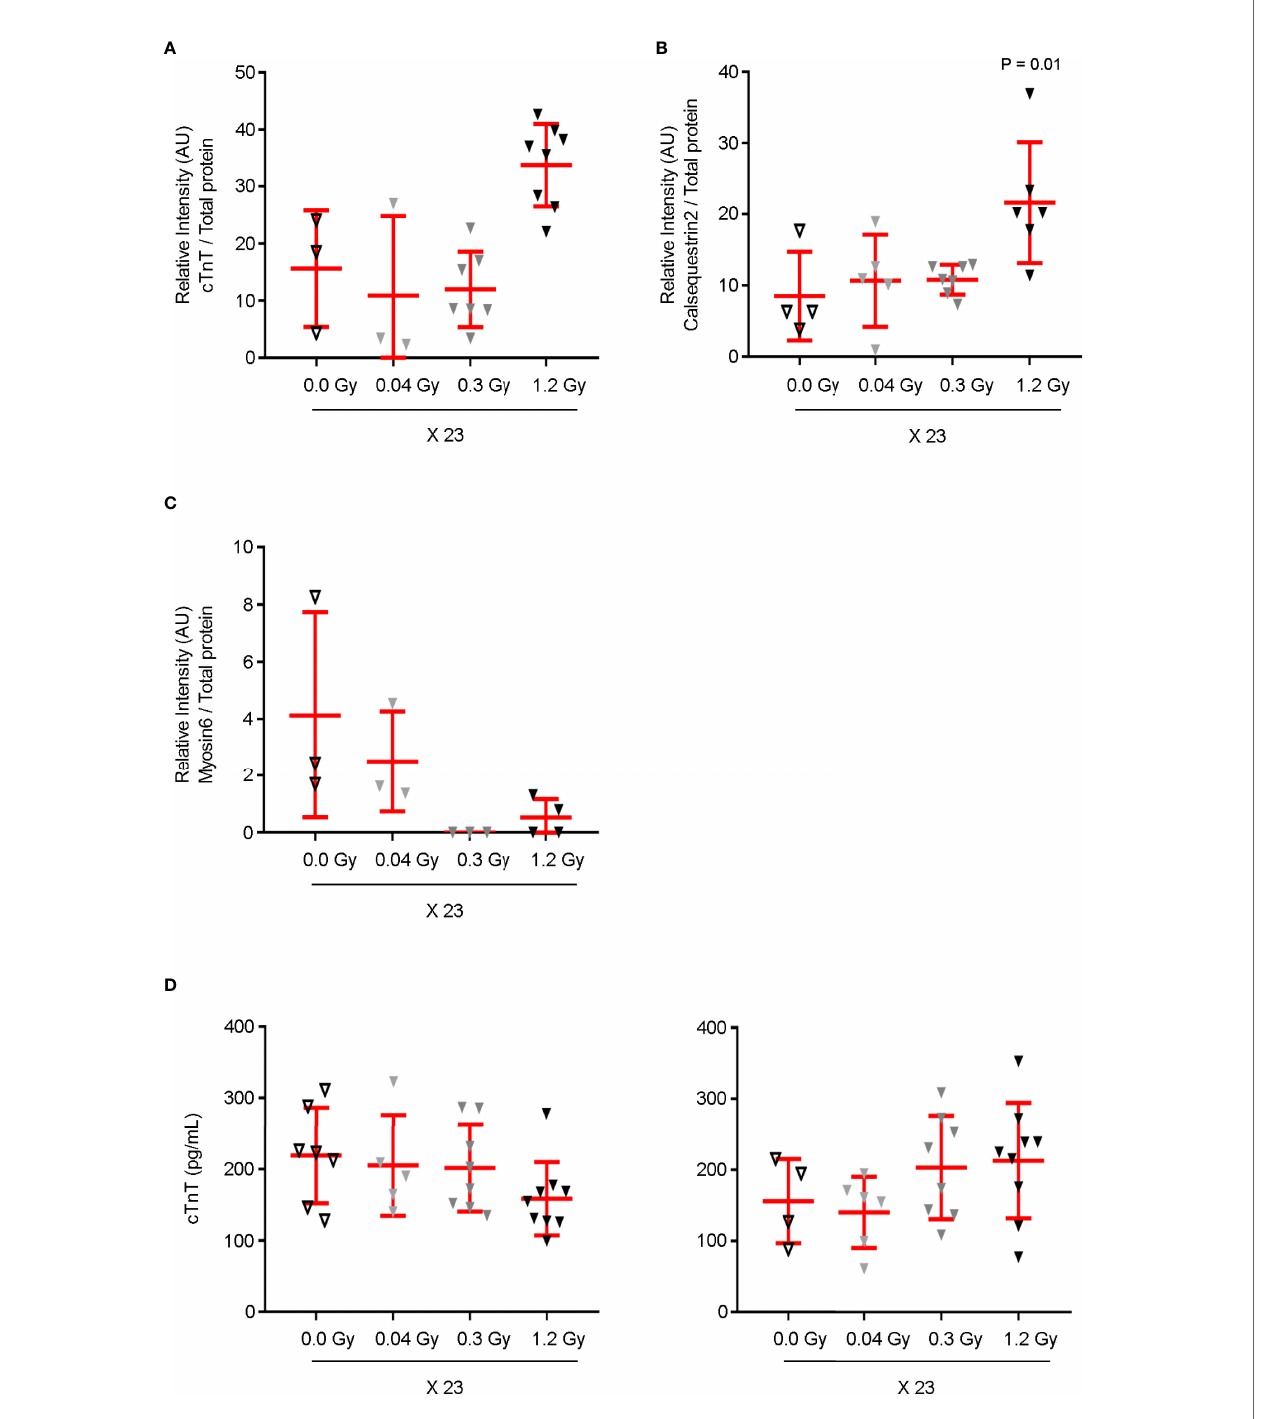
FIGURE 6 | cTnT, Calsequestrin2, and Myosin6 expression levels are modulated in the cardiac tissue by the cumulative doses of 6.9 and/or 27.6 Gy. The cardiac tissue samples used in proteomics were analyzed by western-blot for (A) cTnT, (B) Calsequestrin2, and (C) Myosin6. Protein expression levels are shown as the relative densitometric intensity of the labeled proteins in relation to total protein in each lane. A Kruskal – Wallis test with Dunn ’ s correction was used for statistical analysis. Quantitative analysis shows (A) an increasing trend in the expression level of cTnT and (B) a signi fi cant augmentation of Calsequestrin2 in response to the daily dose of 1.2 Gy. (C) Myosin6 expression levels decrease by both daily doses of 0.3 and 1.2 Gy. (D) Plasma levels of circulating cTnT were assessed at 7 (left) and 12 months (right) after the end of IR exposure. Although no augmentation was detected at 7 months, an increasing trend was found for circulating cTnT in response to 0.3 and 1.2 Gy at 12 months. (A – D) Individual data and mean ± SD (in red) are shown for n = 3 – 9. cTnT, cardiac muscle troponin